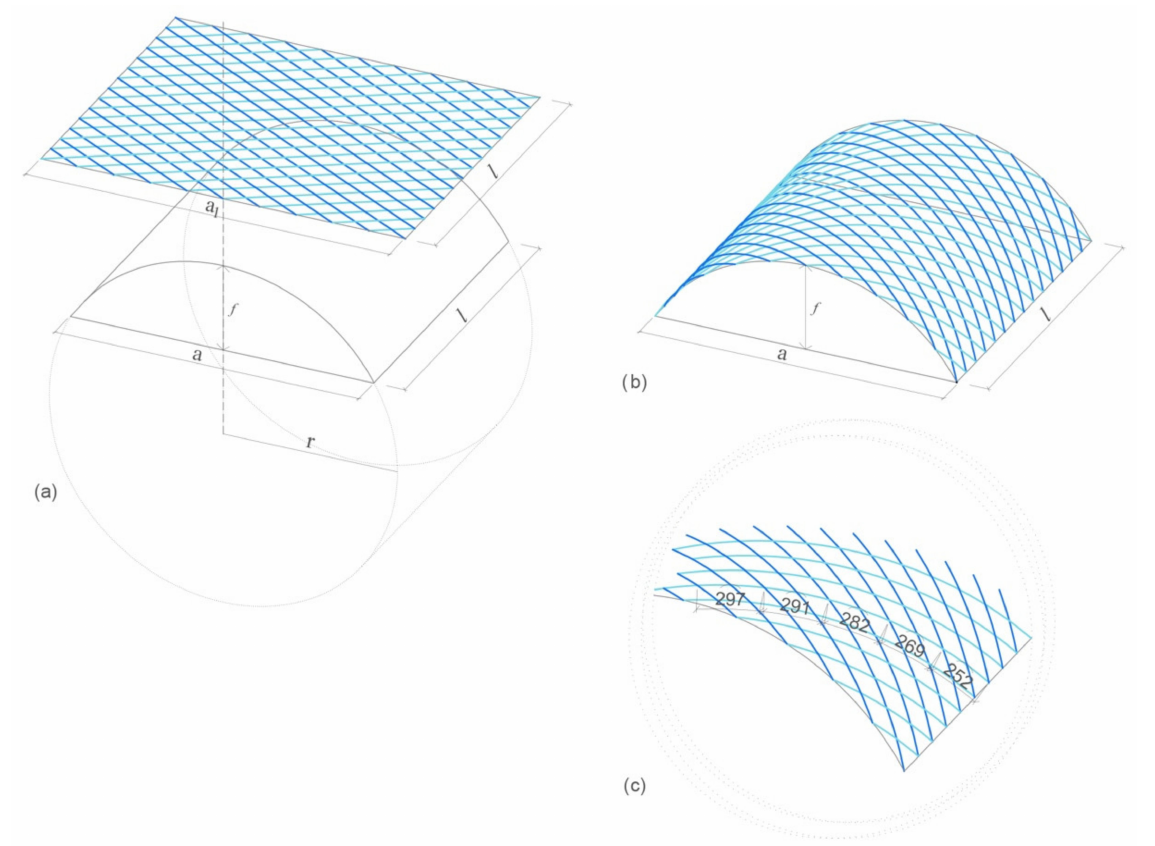
Figure 6. The axonometric view and detail of the lamella vault for the graphical method of projection of the diamond pattern to the cylinder surface: ( a ) the projection plane and the cylinder surface for projection, ( b ) the axis of the lamellae lying on the cylinder surface, ( c ) detail of the lamellae axes showing their different